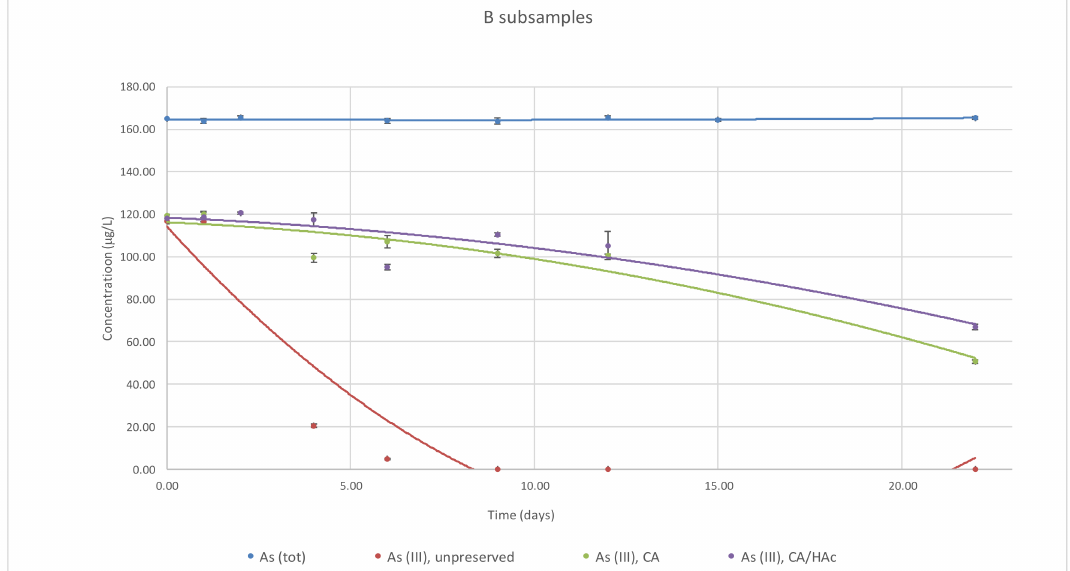
Figure 4. As(III) and As(tot) stability over time, dependent on the preservation treatment used—natural water sample A.